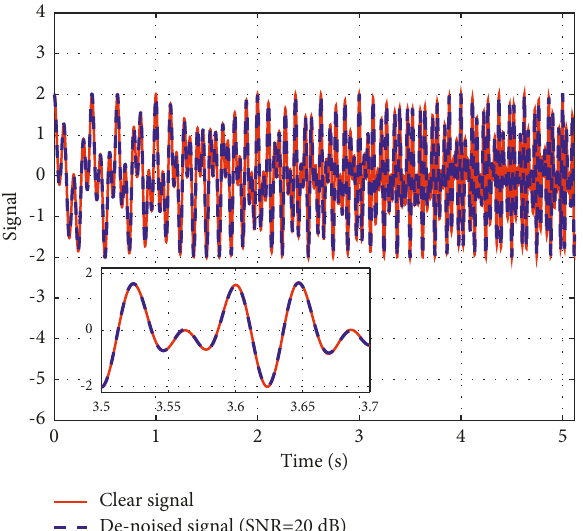
Figure 6: Noise elimination of non-stationary signal using proposed method when SNR � 20